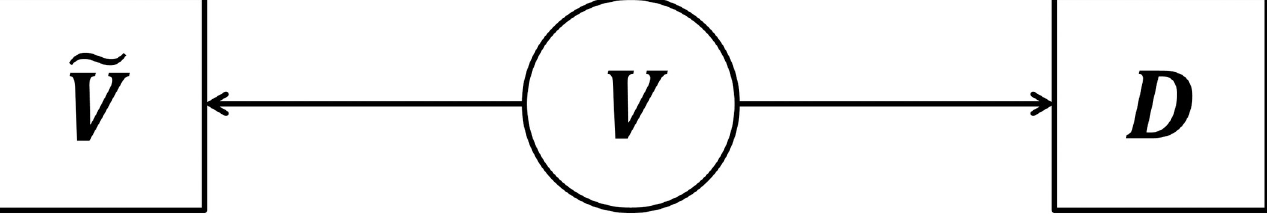
Fig 1. Exposure misclassification model. D : observed true disease status, binary; V : unobserved true vaccination status, binary; ~ V ~ : observed and potentially misclassified vaccination status, binary.